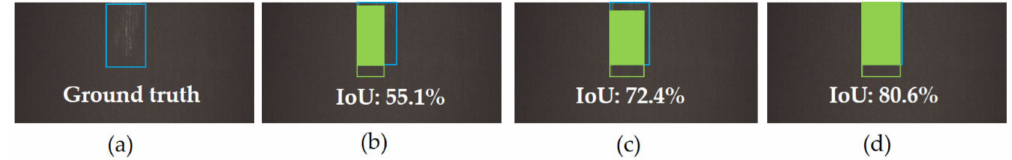
Figure 12. The detected defects and their IoUs by three methods. (The blue boxes are the GT boxes, the yellow boxes are the correct detected boxes.) ( a ) the GT box in the fabric defect image, ( b ) the IoU of RetinaNet, ( c ) the IoU of GA-Faster R-CNN, and ( d ) the IoU of